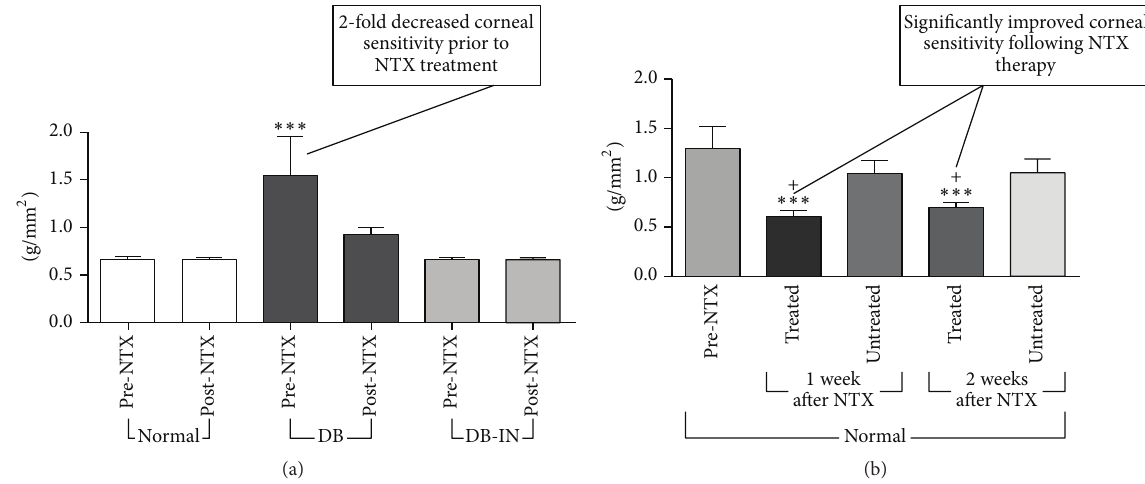
Figure 13: Impact of NTX treatment on corneal sensitivity. (a) Prior to NTX treatment: 2-fold decreased corneal sensitivity in the 8-week DB untreated diabetic rats compared to normal controls (increased force required to generate a response). (b) After NTX treatment, DB sensitivity returned to normal levels with a 2-fold and 1.5-fold increase in sensitivity, respectively, following NTX treatment. There was no effect on corneal sensitivity and there was no effect on normal or insulin treated diabetic (DB-In) rats. Note: in both histograms, higher bar is less sensitive. Values are means ± SEM. Significantly different from NTX at ∗∗∗ 𝑃 < 0.001 and untreated corneas at + 𝑃 < 0.05 (derived from [42]). Height of histogram indicates force required for stimulus to be detected. Higher histogram indicates less